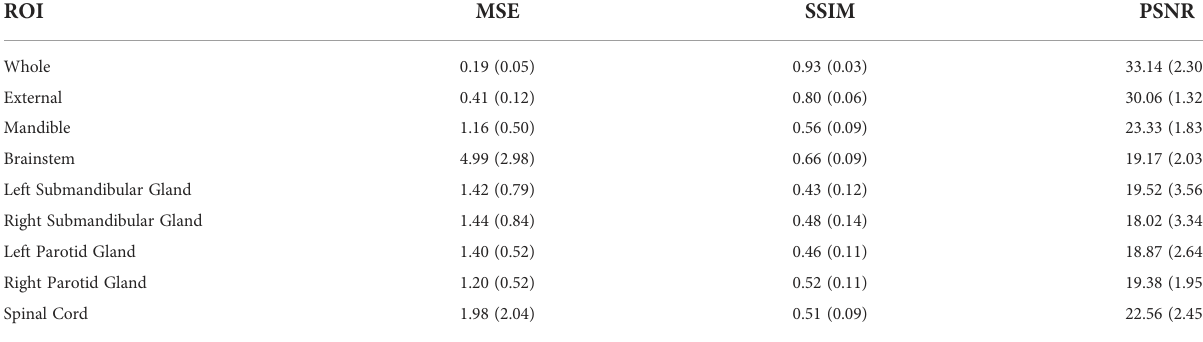
TABLE 2 Image similarity metric results across the whole image and various